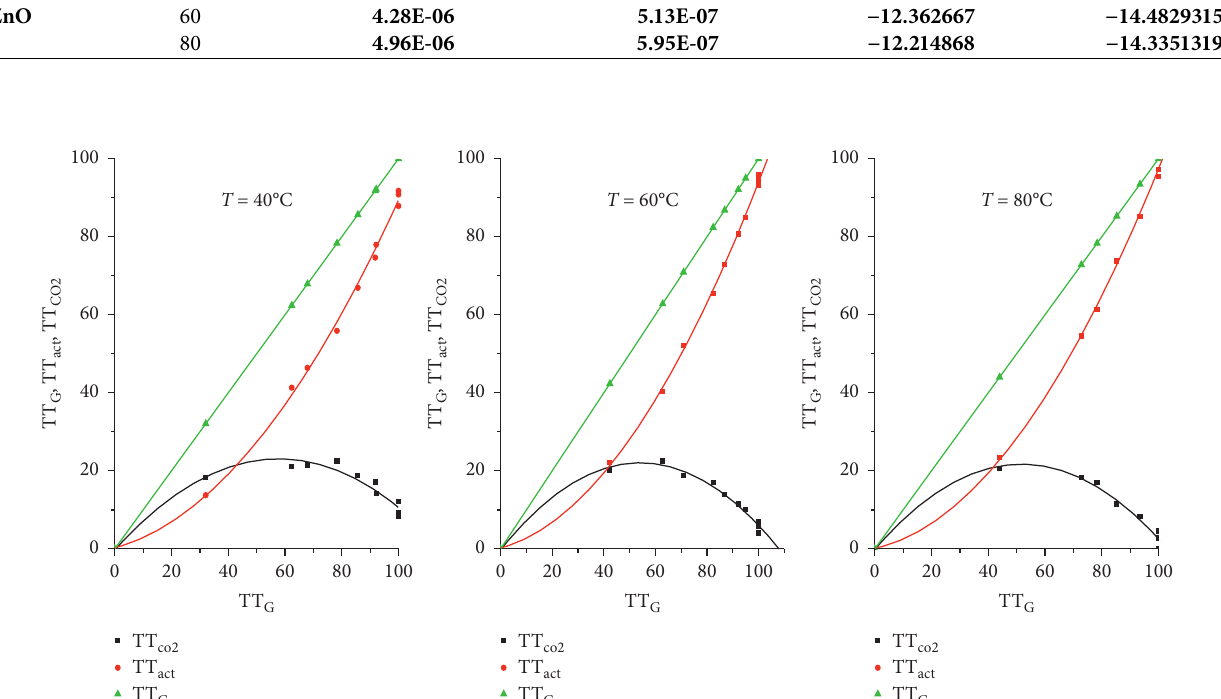
Figure 6: The rate evolution of the transformations TT G and TT acetone and TT CO2 in terms of TT G at different